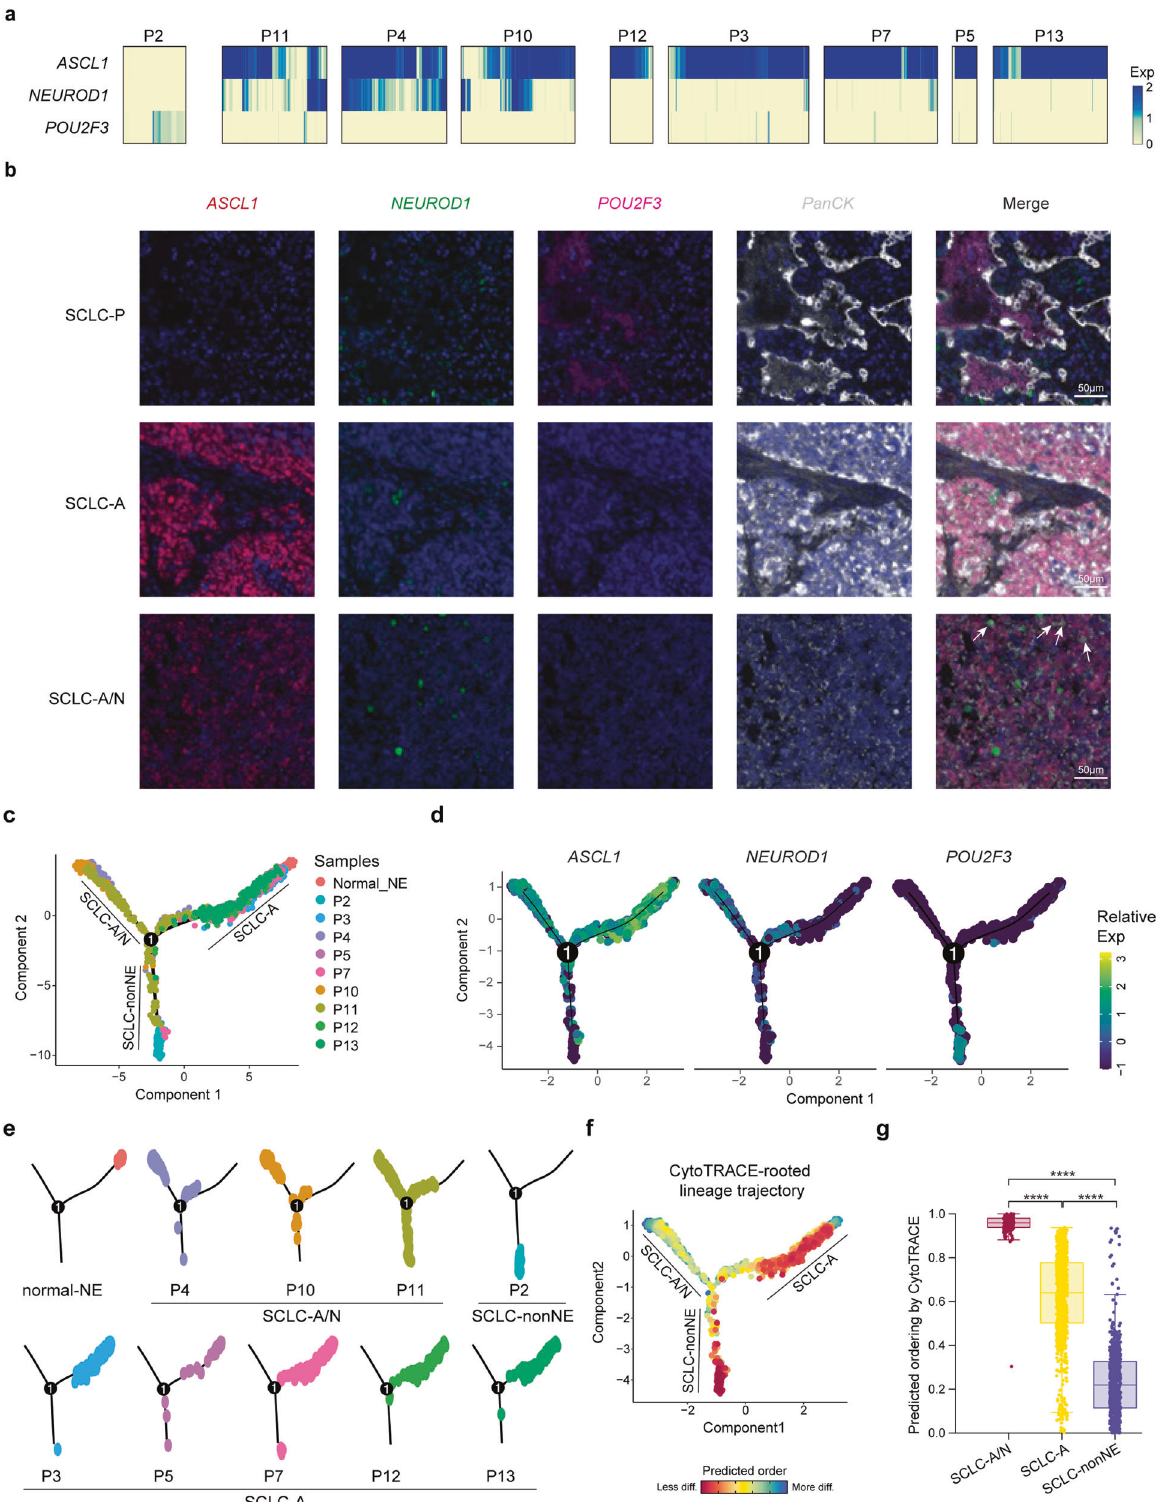
mainly including those associated with neural development, such as NEUROD1 , CHRNA3 , and CNTN2 (Fig. 5b). In SCLC-non-NE cells, a number of genes, such as MYC , CD44 , HES1 , ANXA1/2 , and CXCL1/8 /17 , were highly expressed. MYC , which has been demonstrated in GEMMs to drive a NE-low “ variant ” subset of SCLC with